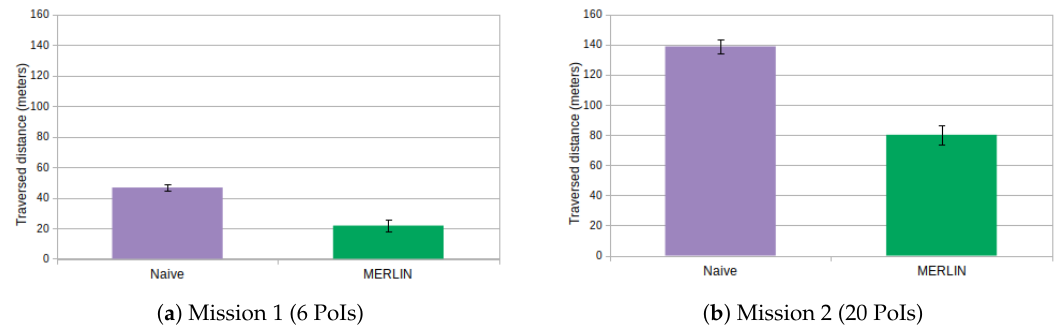
Figure 11. Traversed distances for fulfilling the missions using Naive and MERLIN